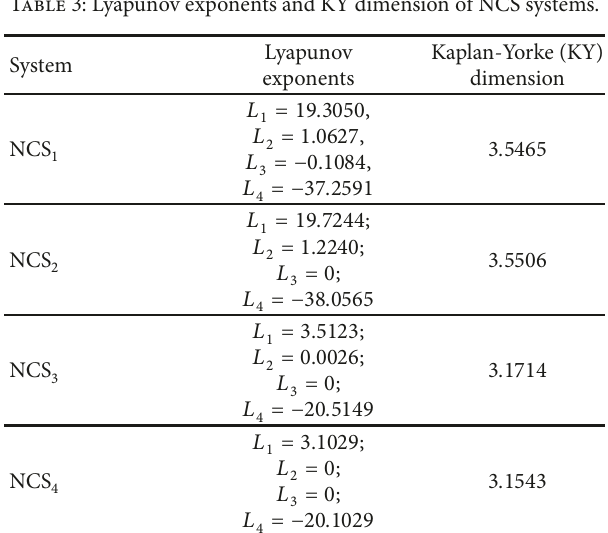
Table 3: Lyapunov exponents and KY dimension of NCS